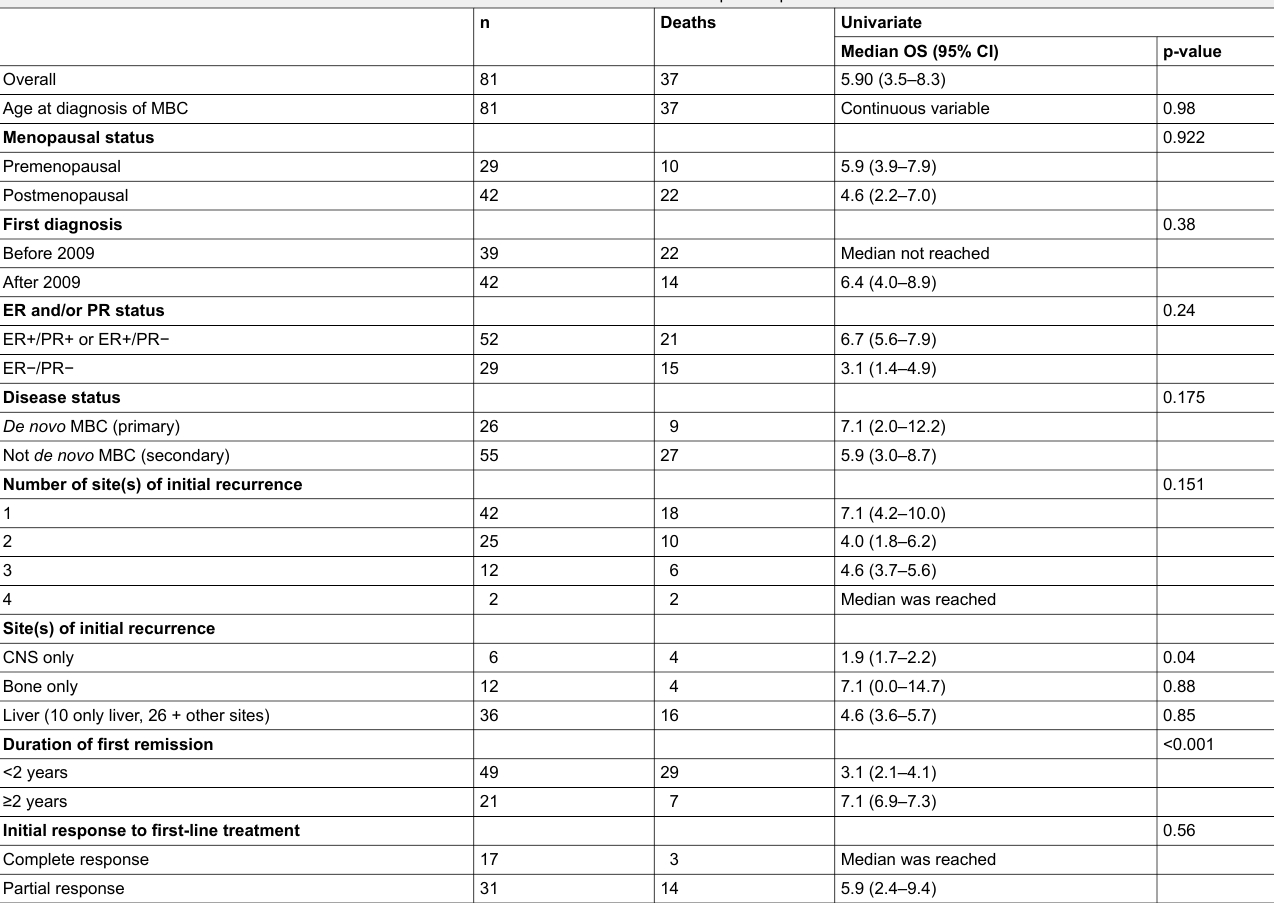
Table 4: Predictors of overall survival from first-line metastatic treatment to death or last follow-up for all patients in the cohort.